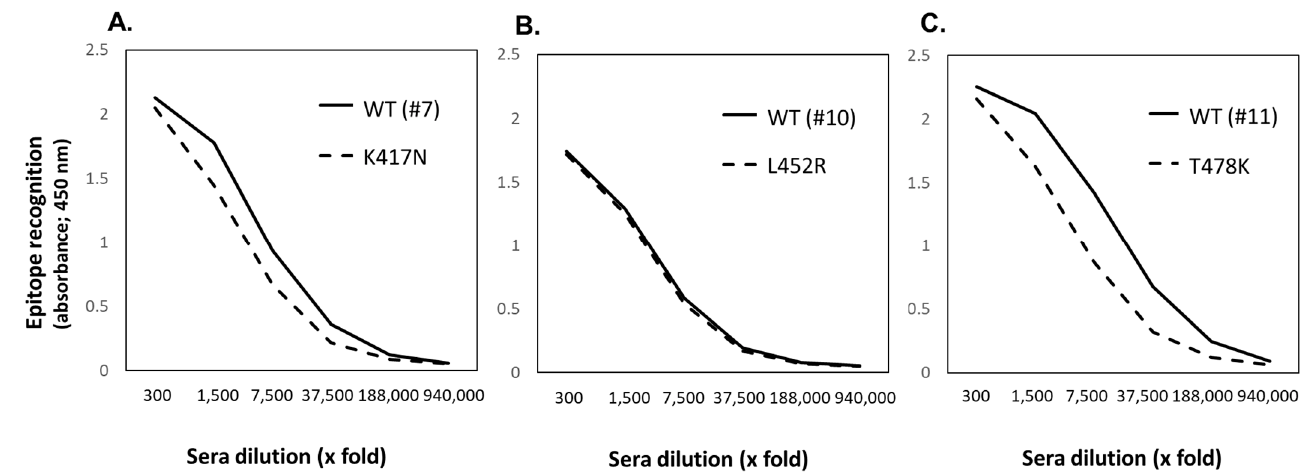
Figure 5. Cross-recognition of Wuhan strain epitope-specific Abs towards mutated epitopes of Omicron/Delta strain ( A – C ). The antisera specific to CPE #7 ( A ), #10 ( B ) and #11 ( C ) epitopes were assessed for cross-recognition towards mutation-inserted epitopes (dotted lines) and corresponding original epitopes (solid lines), respectively. The mutated epitopes synthesized by Fmoc-chemistry were conjugated on maleimide-activated KLH. Then both original CPE epitope and mutated CPE- conjugated KLH were individually coated on the microtiter plate as described in Materials and Methods